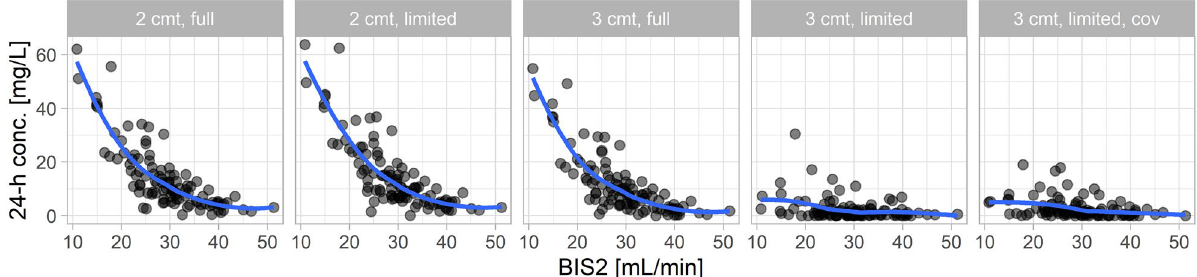
Figure 2. Absolute difference between predicted and observed 1440 min concentrations (dots) versus eGFR values as estimated with the creatinine and cystatin C-based BIS2 equation for the five evaluated models. Two- (2 cmt) and three-compartment (3 cmt) models with random effects for all PK parameters (full) or restricted to CL and V1 (limited). One model with covariates (cov). LOESS (locally estimated scatterplot smoothing) curve (blue line).